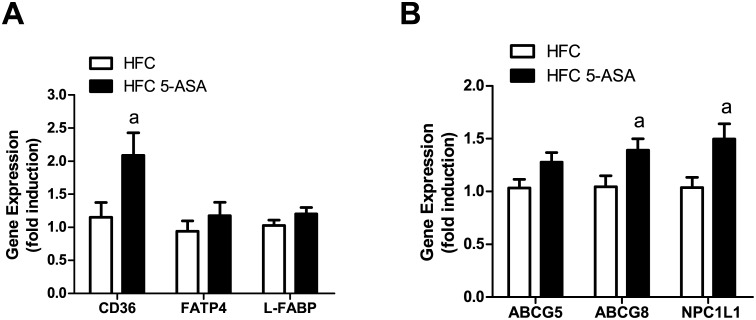
Effects of 5-ASA intervention on lipid translocation in small intestine.(A) qPCR analysis of small intestinal lysates for gene expression of CD36, FATP4 and L-FABP. (B) qPCR analysis of small intestinal lysates for gene expression of ABCG5, ABCG8 and NPC1L1. Data are presented as means ± SEM, n = 9–10 mice, aP < 0.05 vs. HFC.